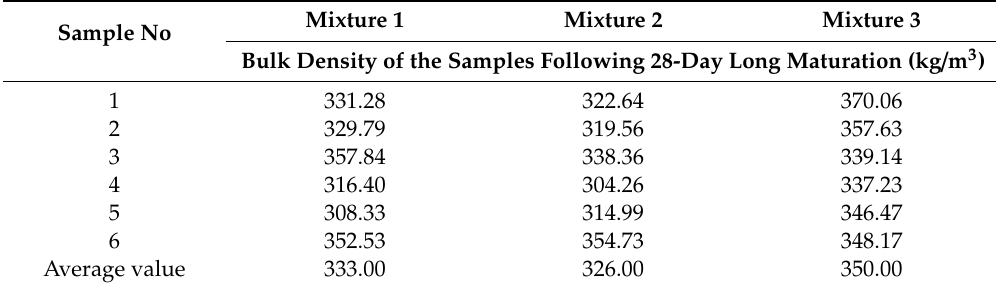
Table 3. Bulk density of the tested mixtures.